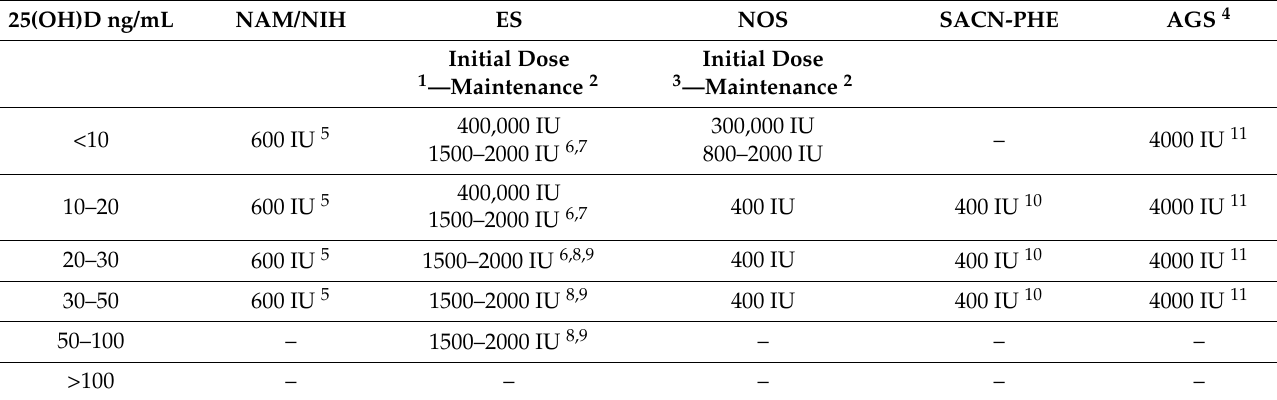
Table 5. Diverse therapeutic dosage of vitamin D recommended by scientific societies and international